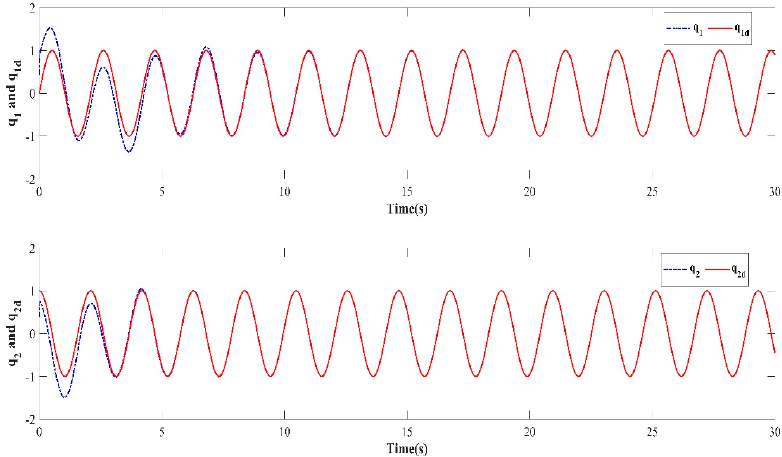
Figure 10. Trajectory tracking effect of the tenth iteration.